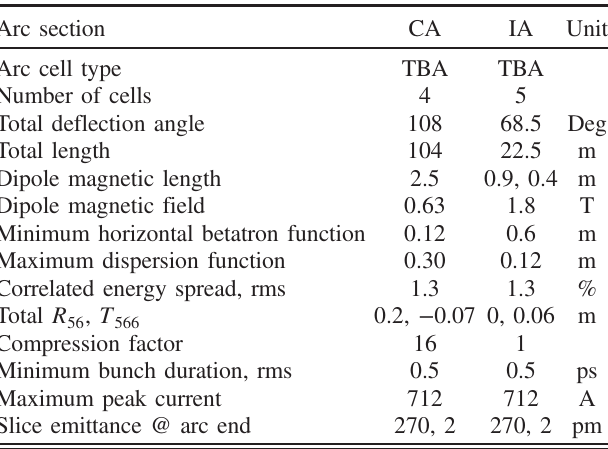
TABLE II. Parameters of magnetic arcs (CA, DA, IA, and EA in Fig. 1).